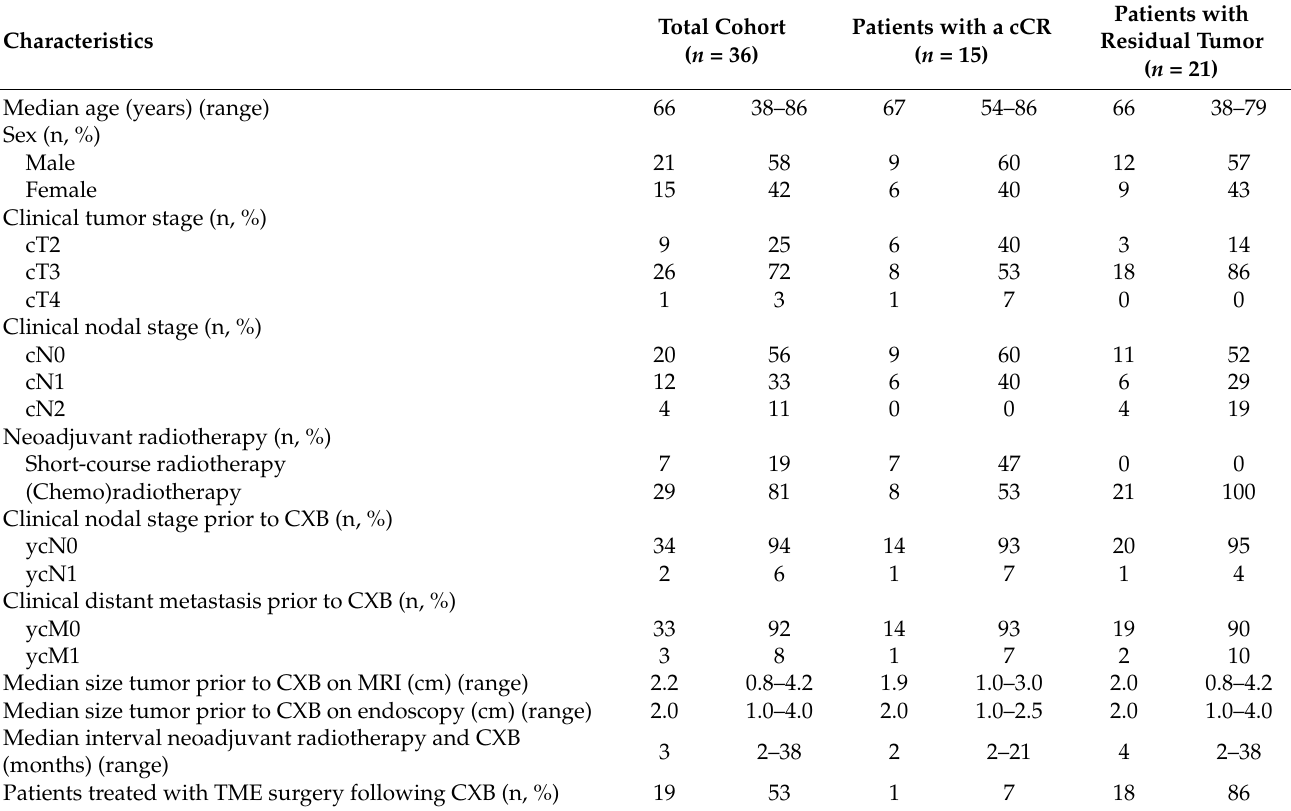
Table 1. Patient characteristics.